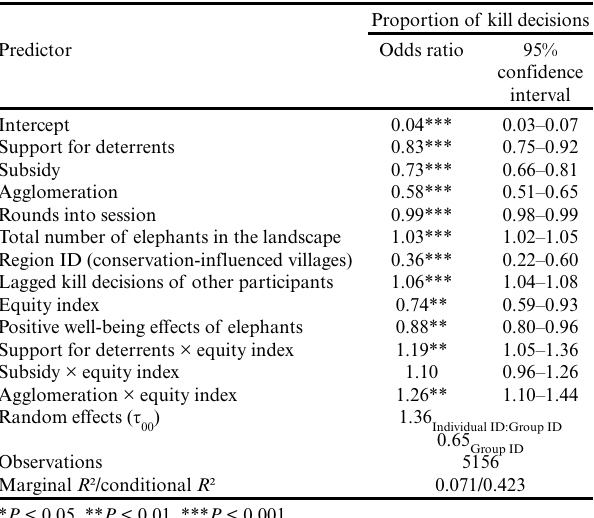
Table 2. Odds ratio estimates from the reduced generalized linear mixed model showing the effect of treatments and other fixed effects on farmers’ propensity to kill elephants in the games. Individuals and groups were included as random